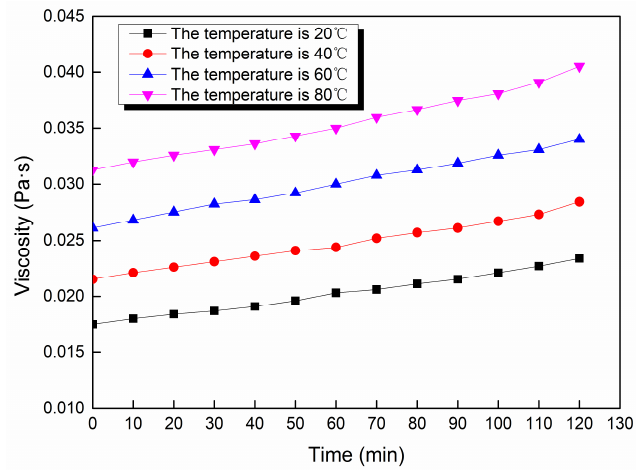
Figure 6. The time-varying viscosity curve of the ordinary cement slurry at different temperatures.